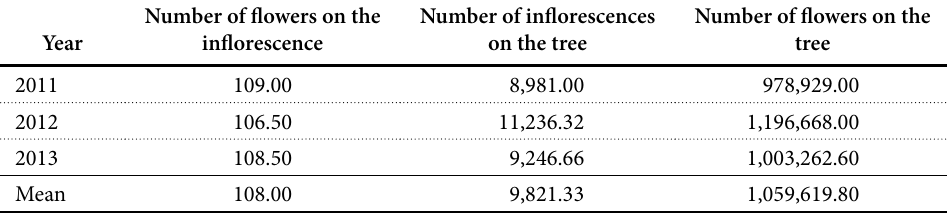
Tab. 1 Abundance of flowering of Acer pseudoplatanus in the years 2011–2013.